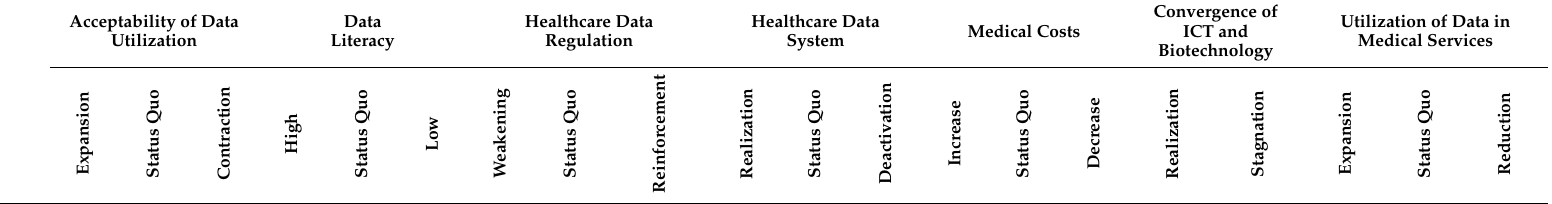
Table 3. Expert evaluation